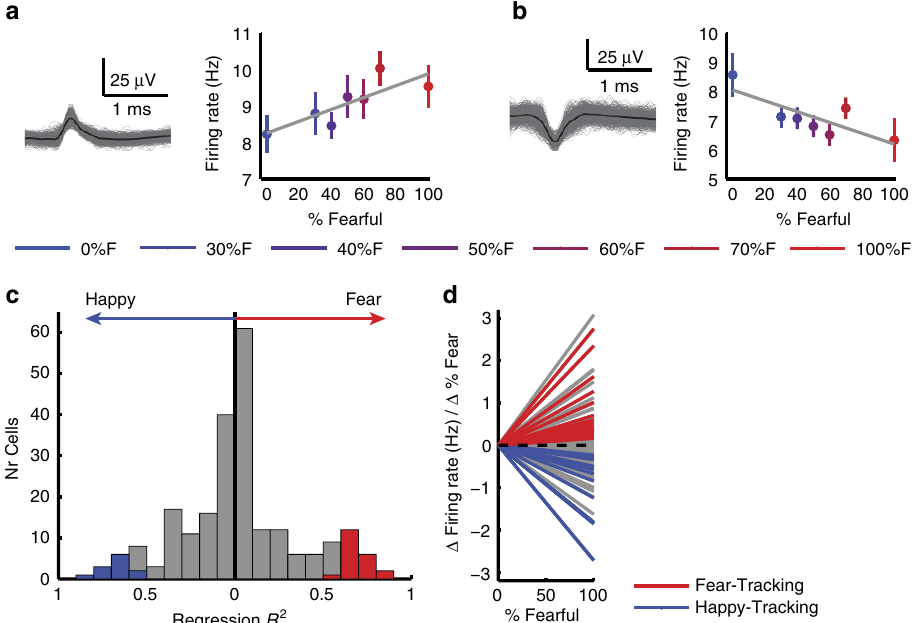
Figure 3 | Emotion-tracking neurons. ( a ) Example neuron that increased its firing rate as a function of %fear (linear regression, P ¼ 0.024). ( b ) Example neuron that increased its firing rate as a function of %happy ( P ¼ 0.032). Right shows the average firing rate for each morph level 250- to 1,750-ms post-stimulus onset. Grey lines represent linear fit. Error bars denote ± s.e.m. across trials. Waveforms for each unit are shown at the left. ( c ) Histogram of regression R 2 . Neurons that had a higher firing rate for fearful faces are shown on the right of 0, whereas neurons that had a higher firing rate for happy faces are shown on the left. Fear-tracking neurons are in red, happy-tracking neurons are in blue, whereas non-emotion-tracking neurons are in grey. ( d ) Slope of linear regression fit. Grey: non-emotion-tracking neurons. Red: fear-tracking neurons. Blue: happy-tracking